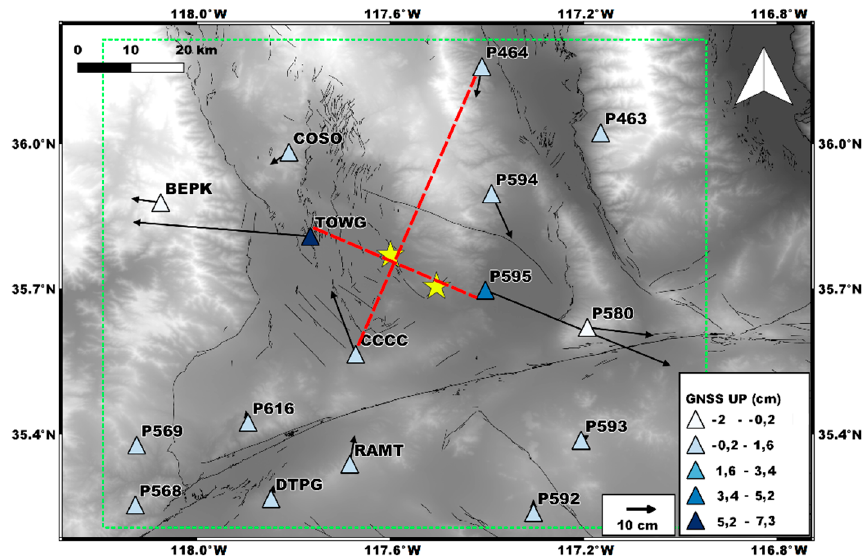
Figure 3. GNSS vertical and horizontal coseismic and early post-seismic displacement due to the cumulative displacement of both the M w 6.4 and M w 7.1 earthquakes of the 2019 Ridgecrest sequence (GNSS coseismic map is shown in figure S1). The yellow stars indicate the two epicenters. The green dashed rectangle represents the area of interest (AOI) on which we focused in this study. The red hyphen lines are the transepts used for profile analysis. The background image is the 90 m SRTM DEM.